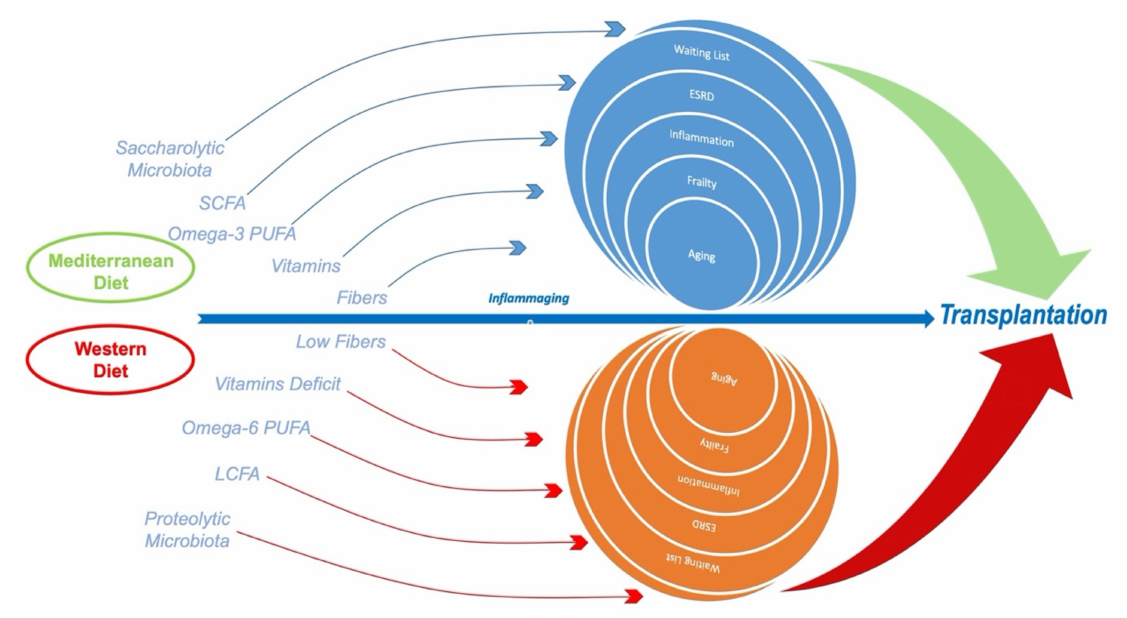
Figure 1. The Mediterranean diet, compared to Western diet, is based on the increased intake of long-chain fatty acids from fish and plant oils; fibers through legumes, fruits, and vegetables; and whole food grains. This approach may lead to better controls of inflammaging and malnutrition in end-stage renal disease (ESRD) with successful renal